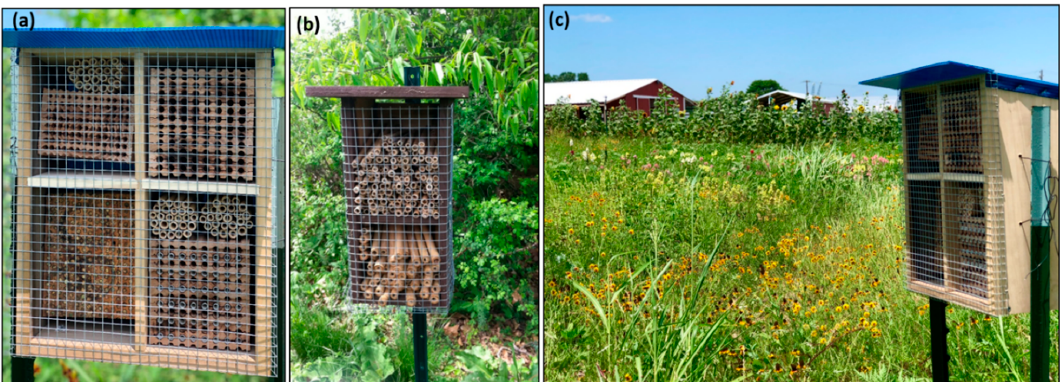
Figure 3. Different types of nest supplementations for mason and leafcutter bees ( a , b ) and deployment of a nest box (also known as Bee Hotel) in bee habitat ( c ). Pictures by N.